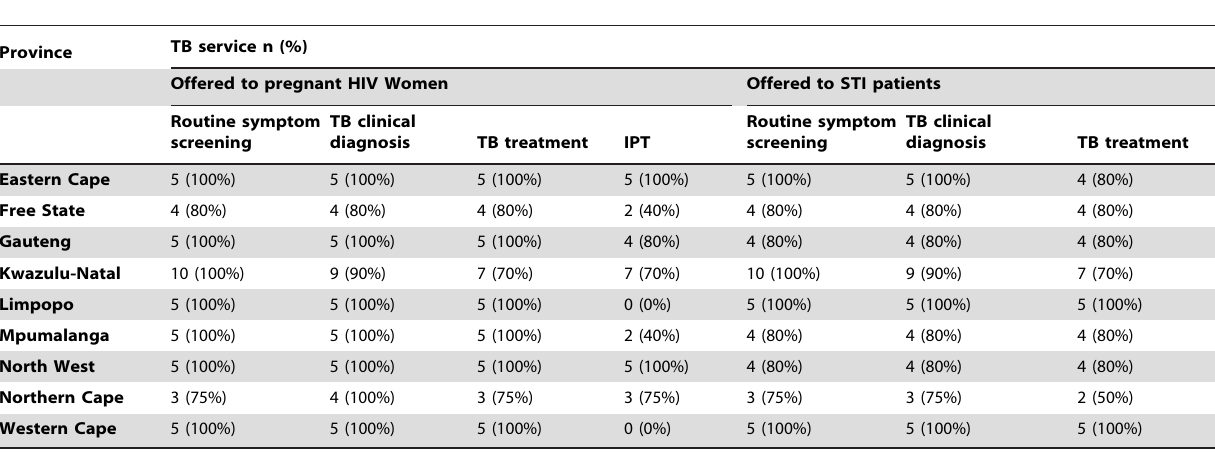
Table 4. Availability of TB services to pregnant HIV-infected and STI patients in selected sites (N =49) by province in South Africa, March